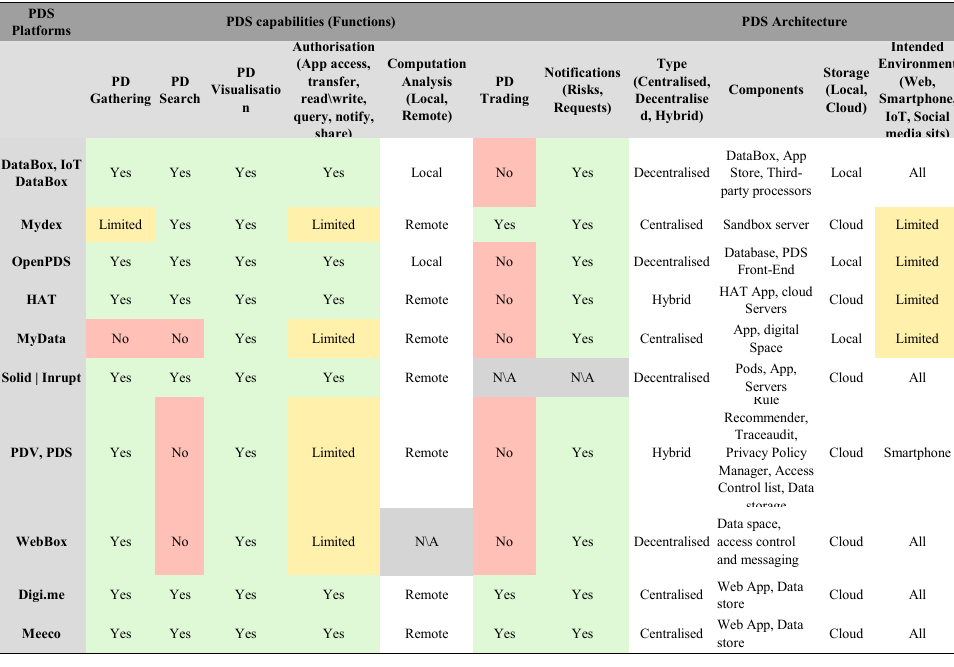
Figure 4. Analysis of the capabilities and architecture in PDS. (HAT [77], Mydex [78], PDV [81], Personicle [83], Meeco [84], MyData [28], OpenPDS [26], Webbox [87], Databox [38], SOLiD [88], Digi.me